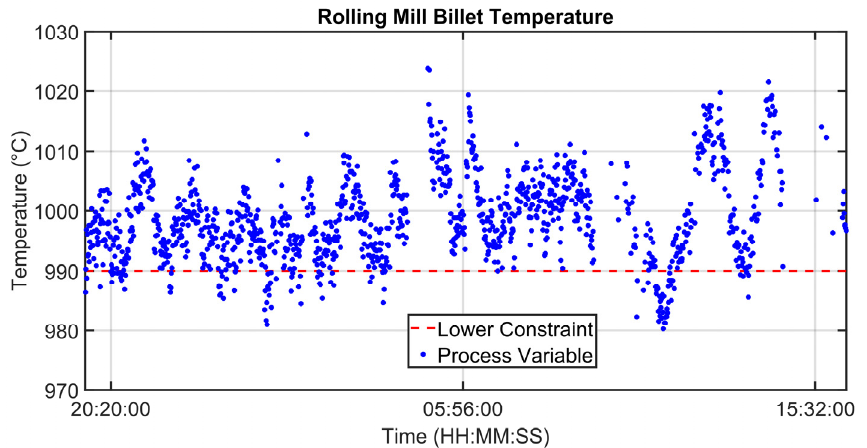
Figure 9. Control results: billets temperature at furnace inlet pyrometer.